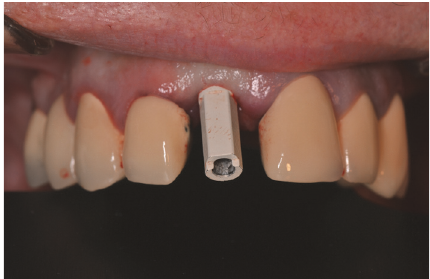
Figure 4: Implant insertion with hand ratchet. The ratchet connec- tor has six green vertical landmarks (corresponding to implant hex) and a horizontal reference line. In order to reproduce the planned implant position, the horizontal reference line should match with the upper border and the green vertical landmark with the window of the surgical template.